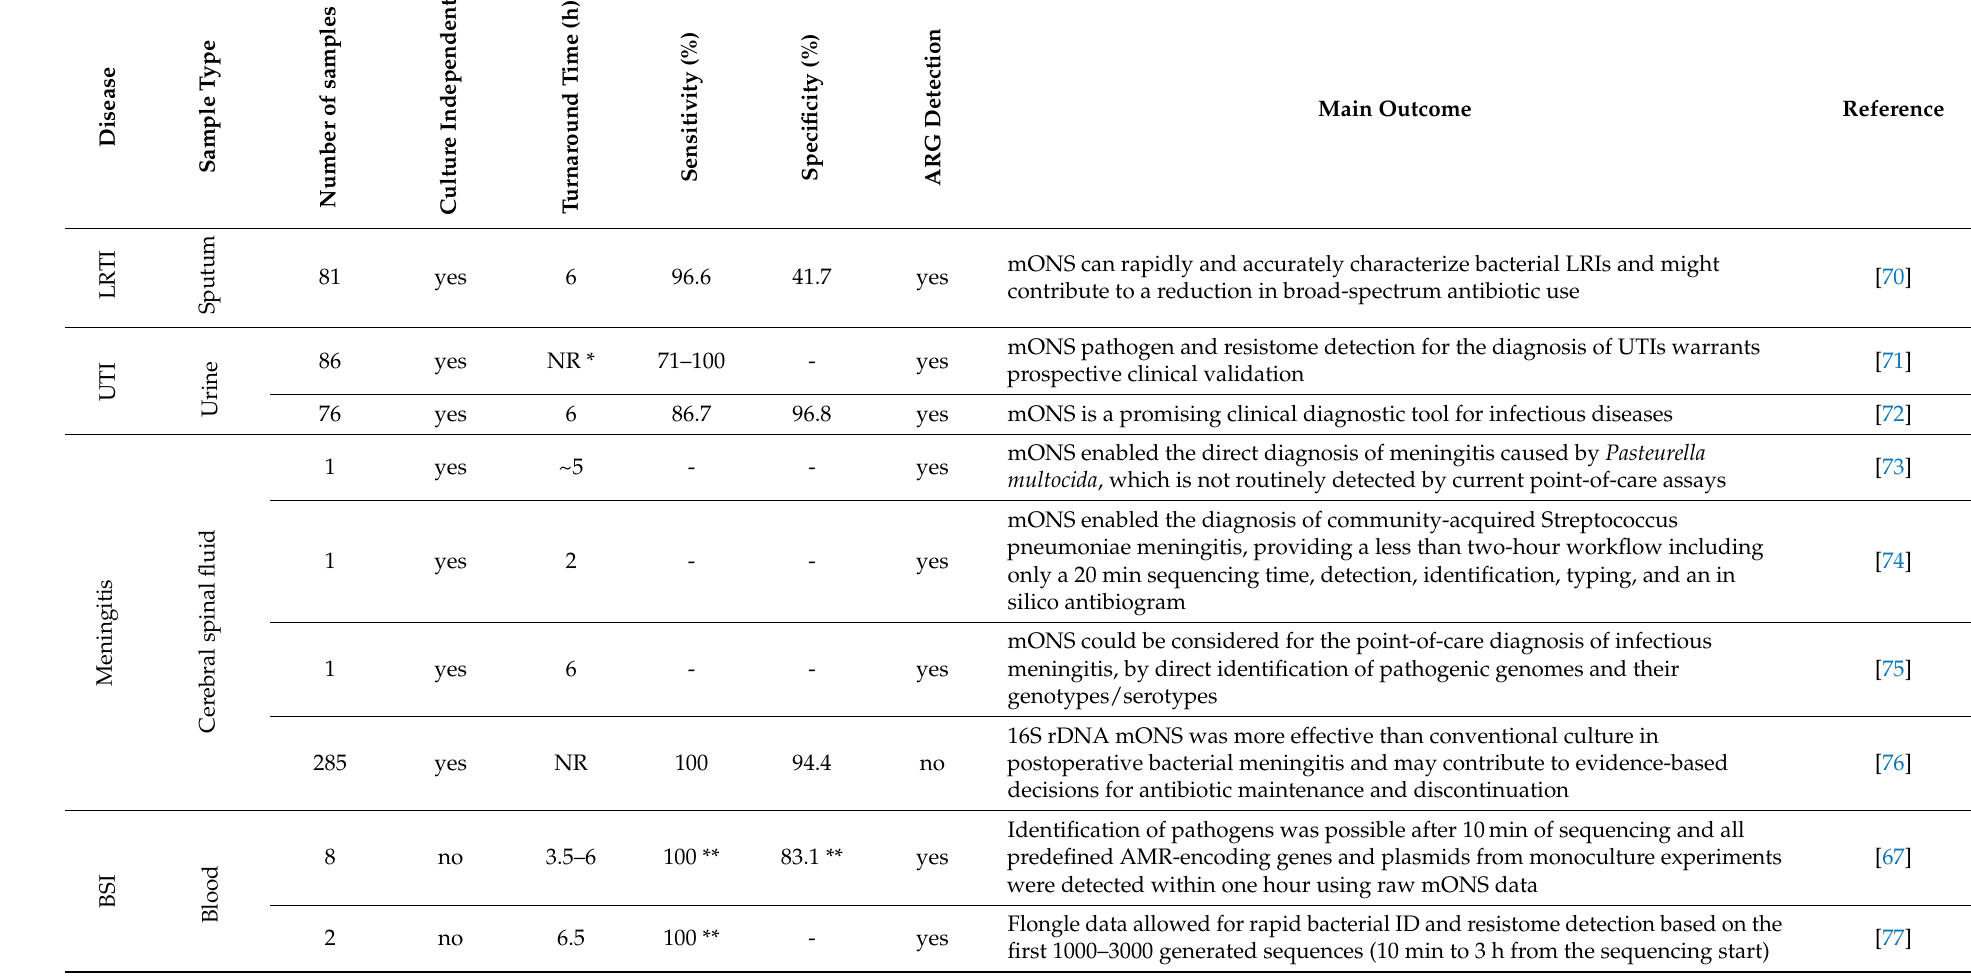
Table 1. The use of real-time metagenomic Oxford Nanopore sequencing (mONS) for infection identification and ARG detection. LRTI: lower respiratory tract infection, UTI: urinary tract infection, BSI: bloodstream infection, SSI: surgical site infection, PJI: prosthetic joint infections, IBS: intraoperative bile aspirates, JF: joint fluid, PT: prosthetic tissue. * NR: not reported, ** the number of analyzed samples <10, and sensitivity/specificity estimates should be treated with